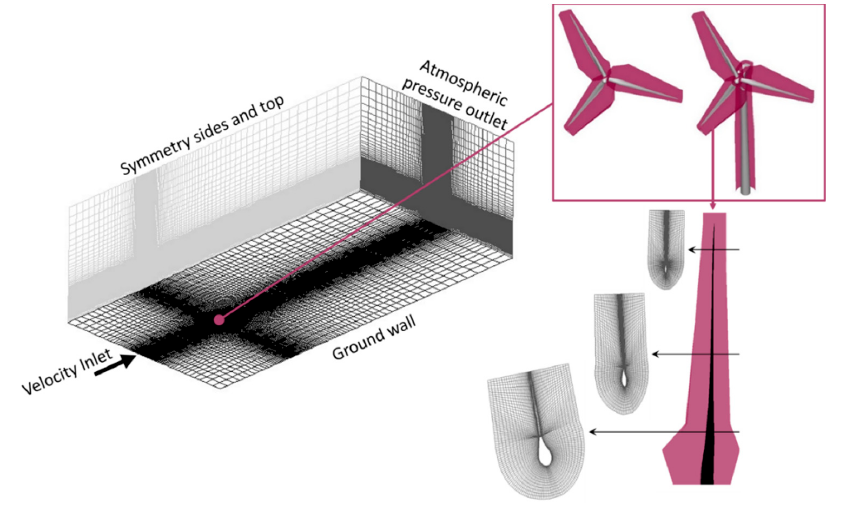
Figure 1. Layout of the performed simulations with details of the ( left ) background and ( right ) component meshes. Symmetry right side and top surfaces are omitted for clarity.